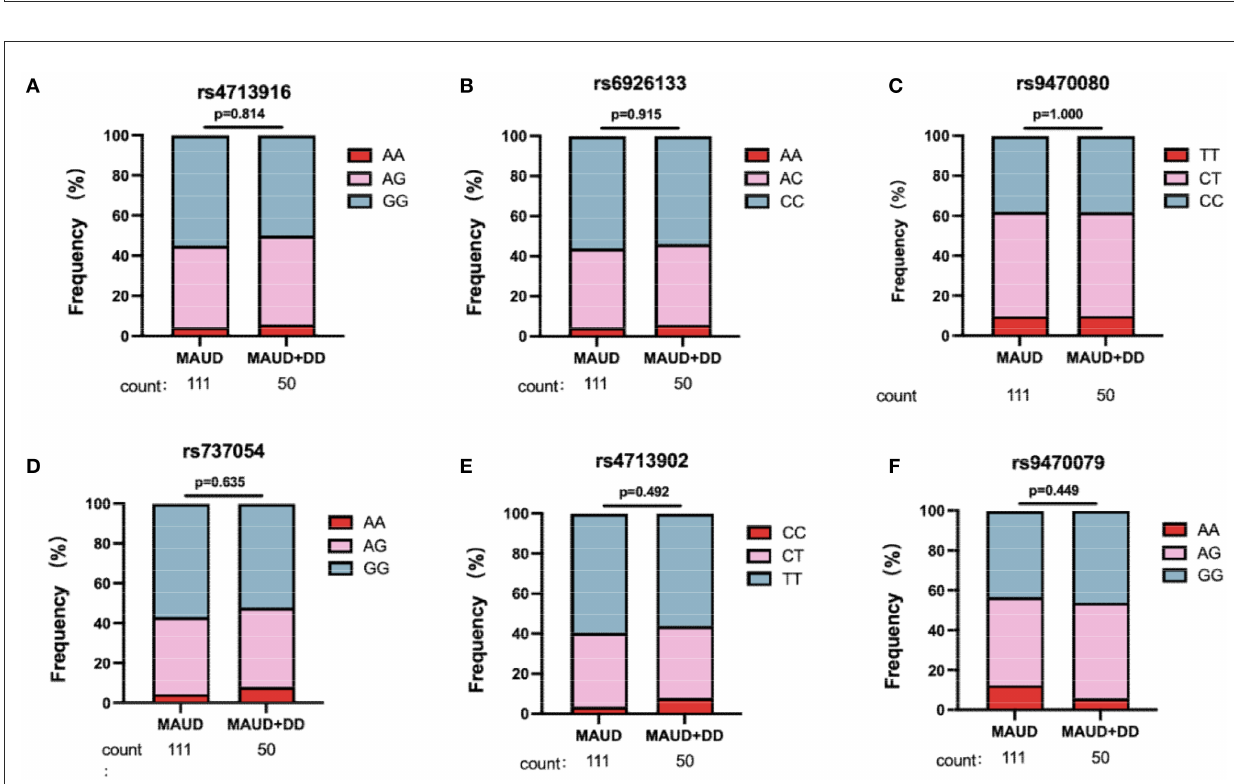
FIGURE2 Genotypic distribution for six FKBP5 SNPs. In 161 patients with MAUD, 50 individuals were comorbid with DD. Genotypic distribution of FKBP5 SNP rs4713916 (A) , rs6926133 (B) , rs9470080 (C) , rs737054 (D) , rs4713902 (E) , and rs9470079 (F) in 111 MAUD patients without DD and 50 MAUD patients with DD. There was no significant difference in the distribution of the six SNP alleles between the two groups, which hinted that the six FKBP5 SNPs were not associated with the occurrence of DD in patients with MAUD (chi-square test). MAUD, methamphetamine use disorder; DD, depressive